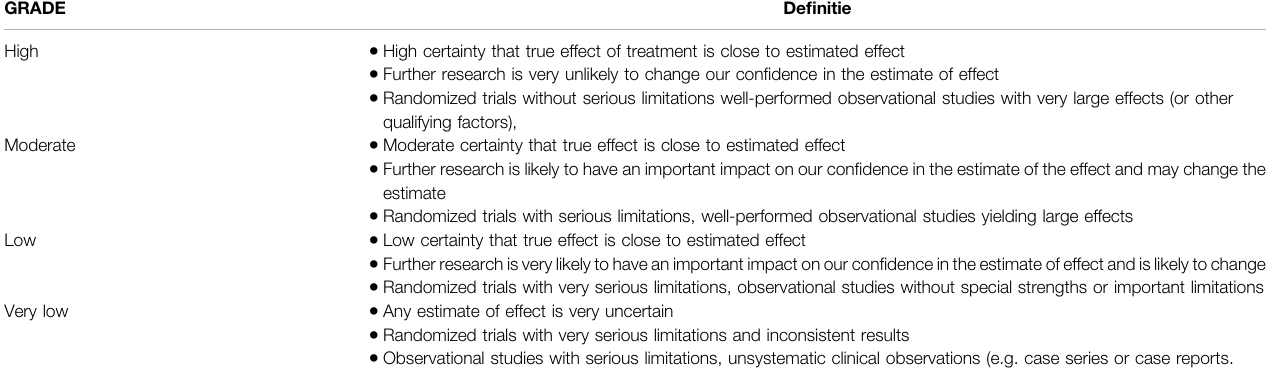
TABLE 1 | GRADE levels of quality of scienti fi c evidence. GRADE De fi nitie High